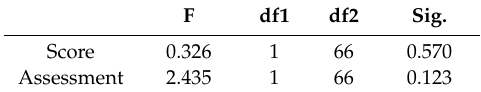
Table 8. Results of the ANOVA analysis for testing the significance of type of e-learning activity. Sum of Squares